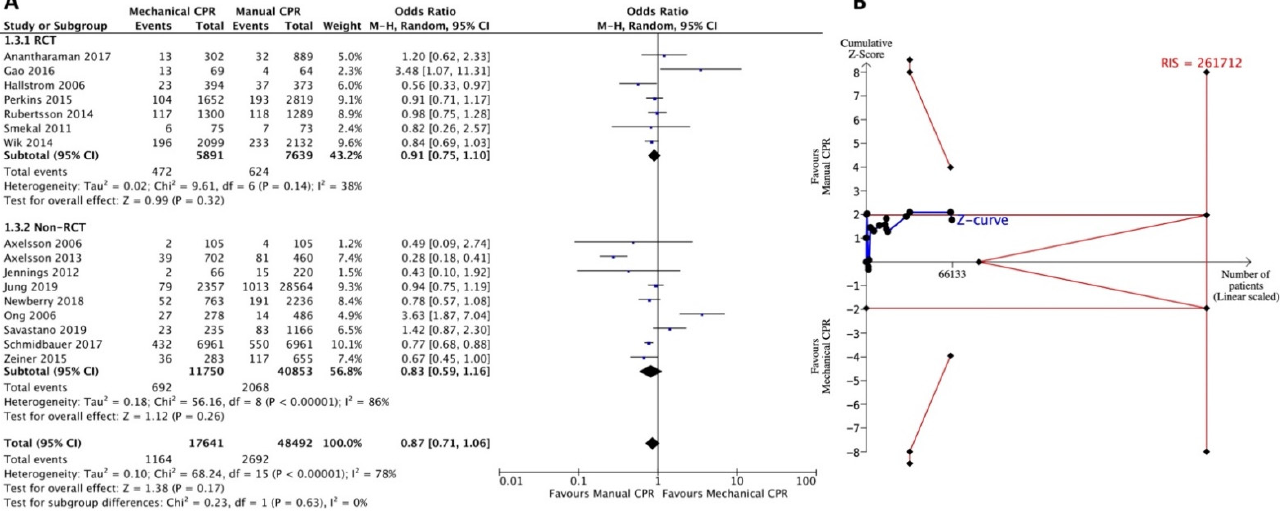
Figure 4. Forest plot ( A ) and trial sequential analysis ( B ) for survival to discharge between mechanical CPR device and manual CPR. CPR: cardiopulmonary resuscitation; CI: confidence interval; RCT: randomized controlled trial; RIS: required information size.